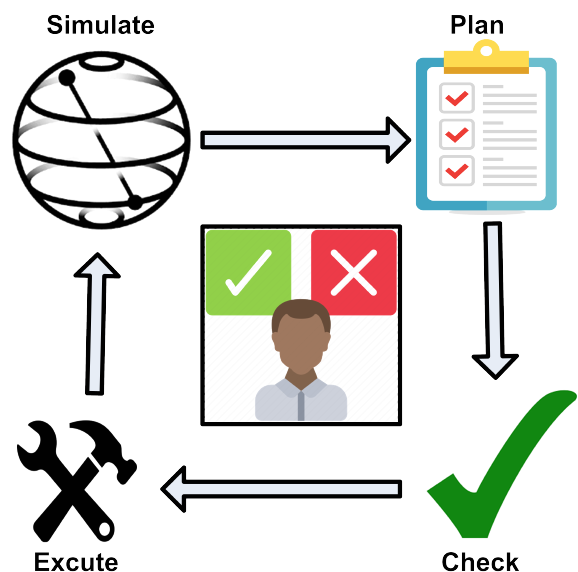
Figure 6. Simulation-based